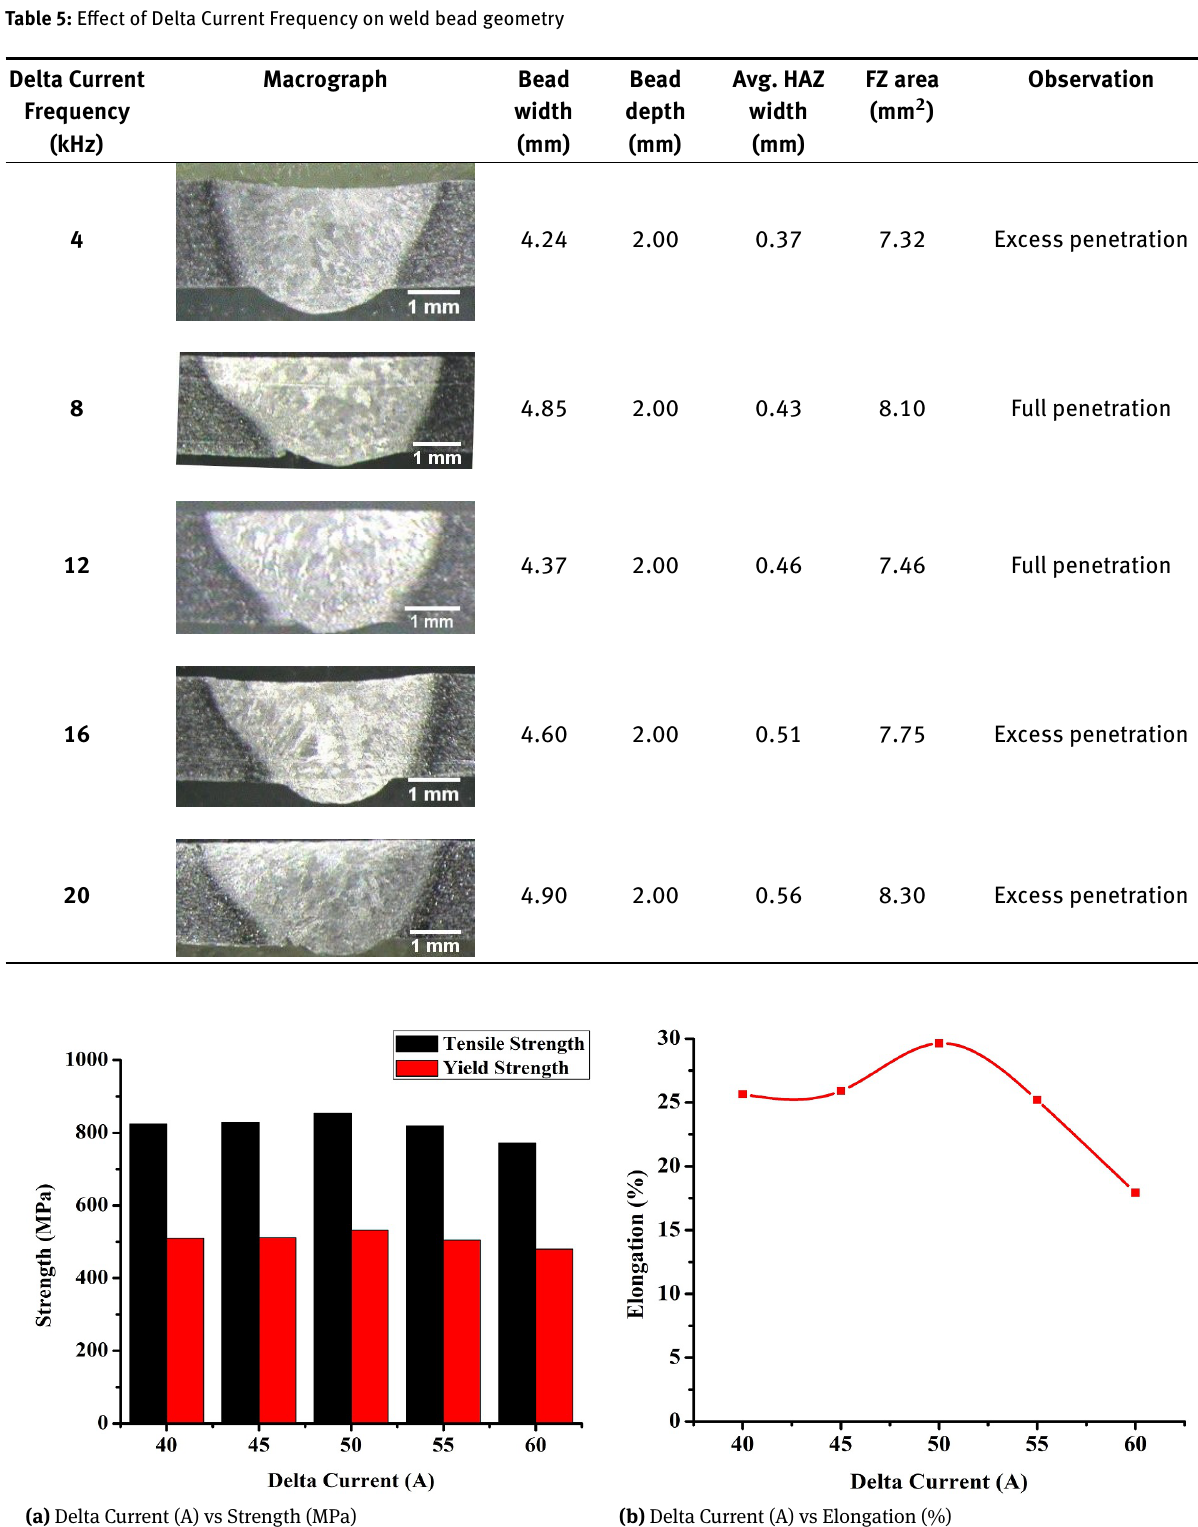
Figure 6: Effect of Delta Current on tensile properties of welded